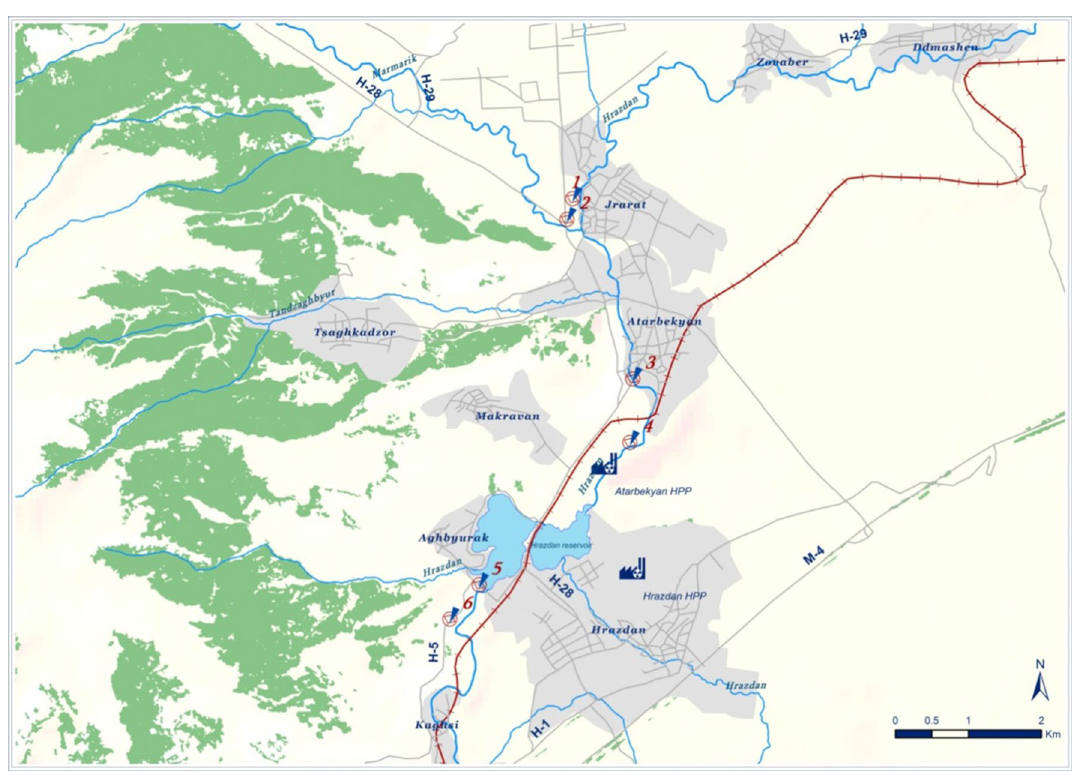
Fig. 1 Map of the study area and the locations of sampling